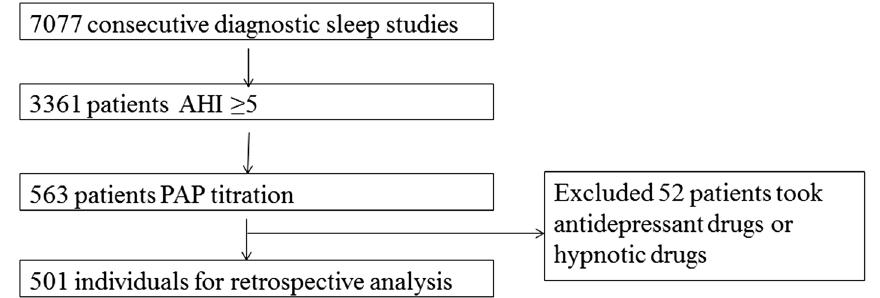
Figure 1. Flowchart for study